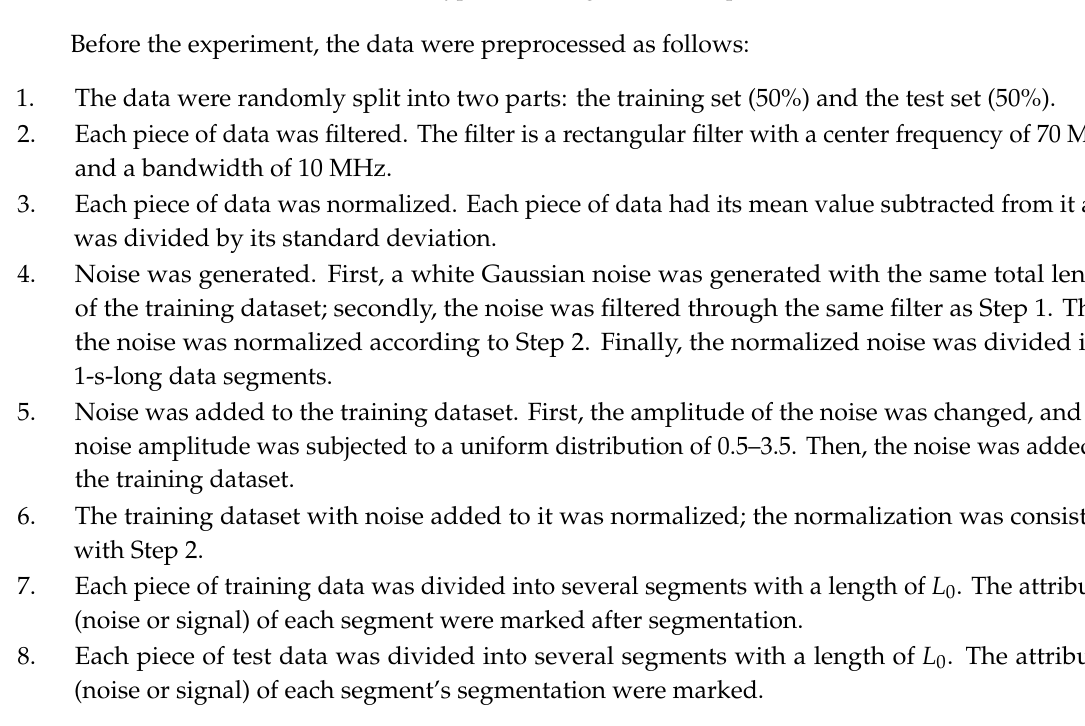
Figure 7. A typical radio signal for the experiment.